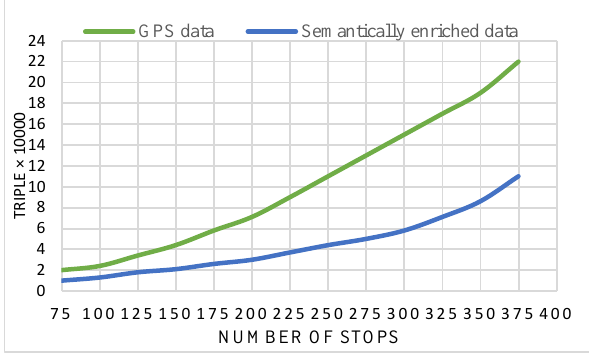
Figure 14. Reasoning storage space taken using GPS data and semantically enriched